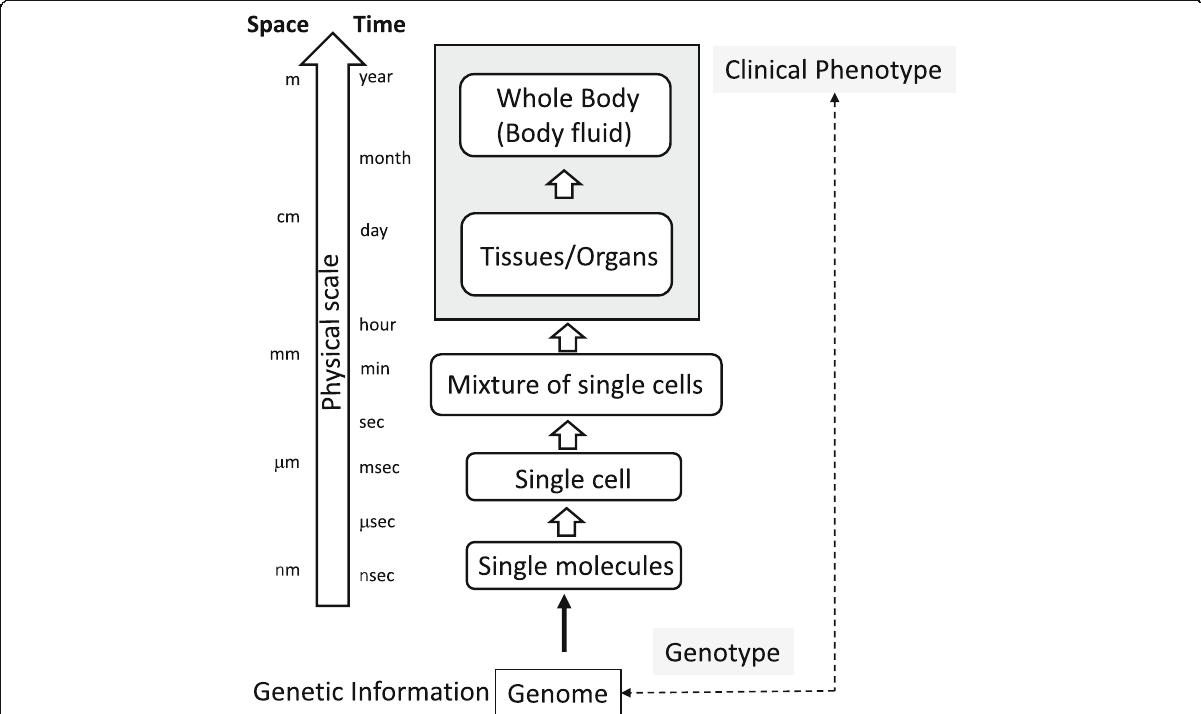
Fig. 2 Multi-scale structure of the biological system. The genome information is spatiotemporally decoded into proteins according to the central dogma. The biological system consists of multiple physical layers, which have their own time and space scales. Genotype information of events observable at macroscopic layers (clinical phenotype) is known in disease research. To get a comprehensive understanding of the etiology of genetic diseases, we must analyze molecular events on each layer located between the genotype and clinical